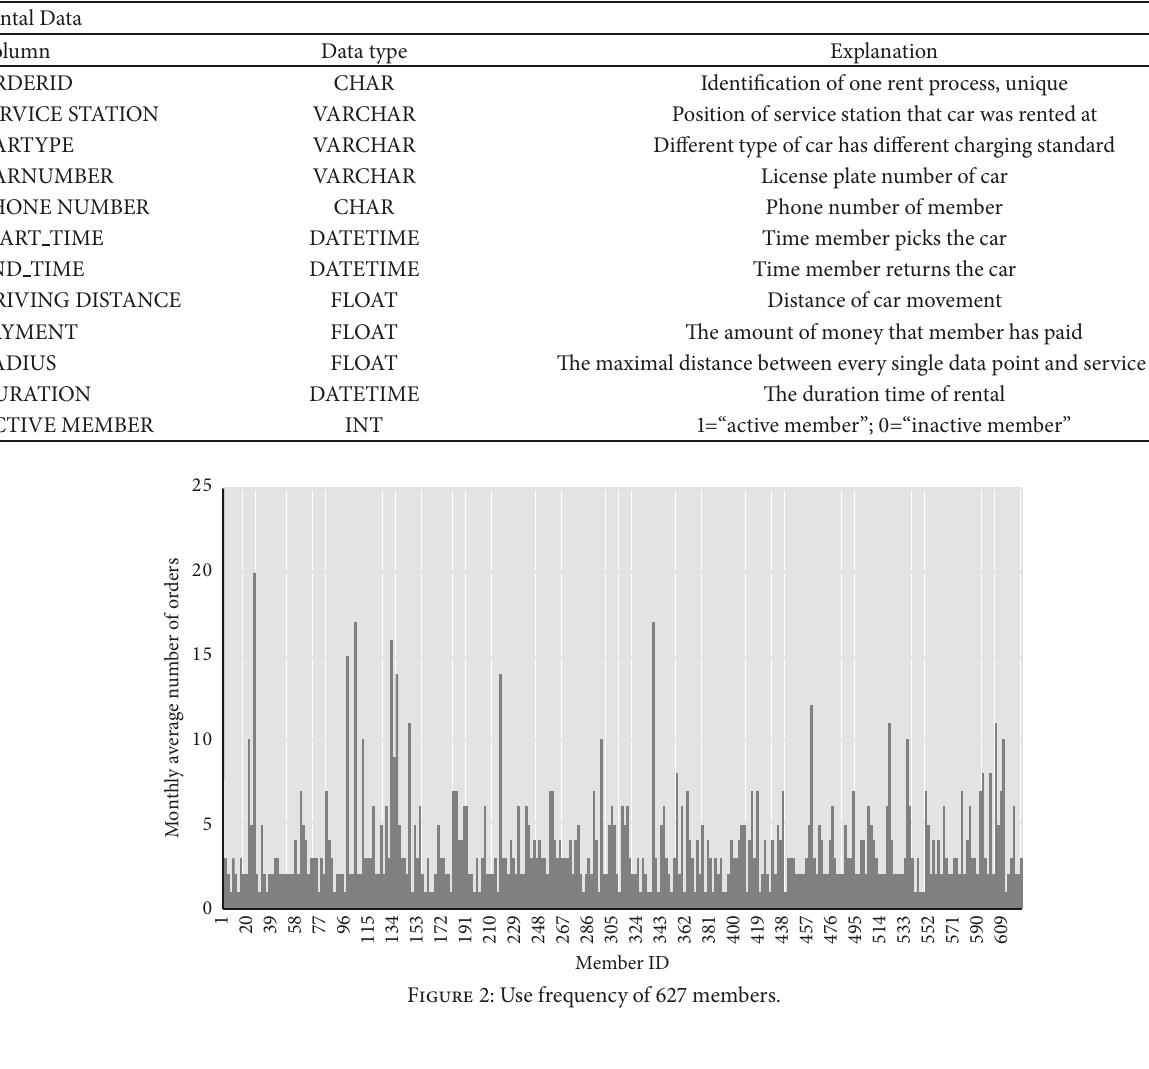
Table 1: Data frame of rental data.